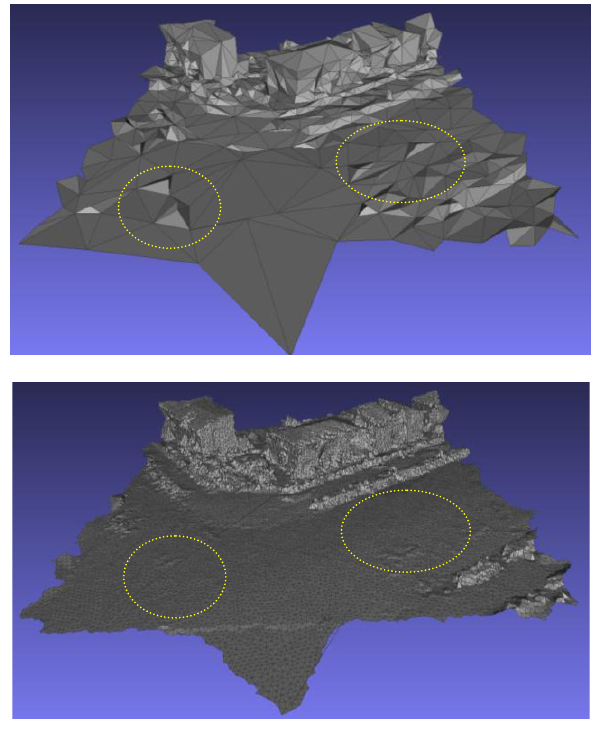
Figure 5. Original 3D TIN generated from aerial imagery (top) & final 3D TIN after data fusion